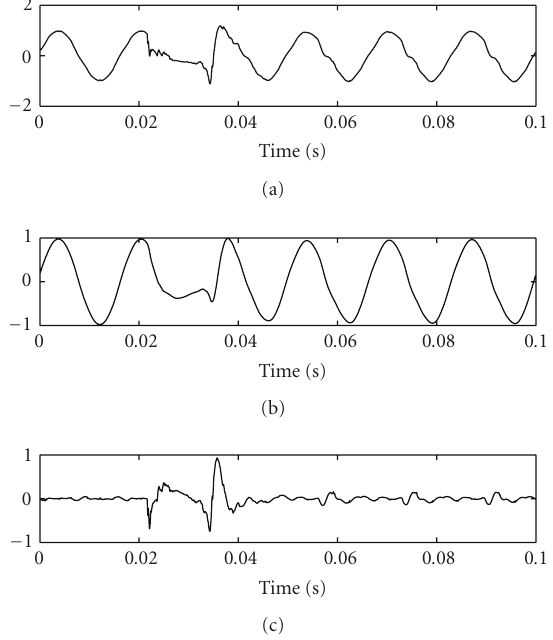
Figure 14: (a) Signal { x ( n ) } , (b) signal { f ( n ) } , (c) signal { u ( n ) } .